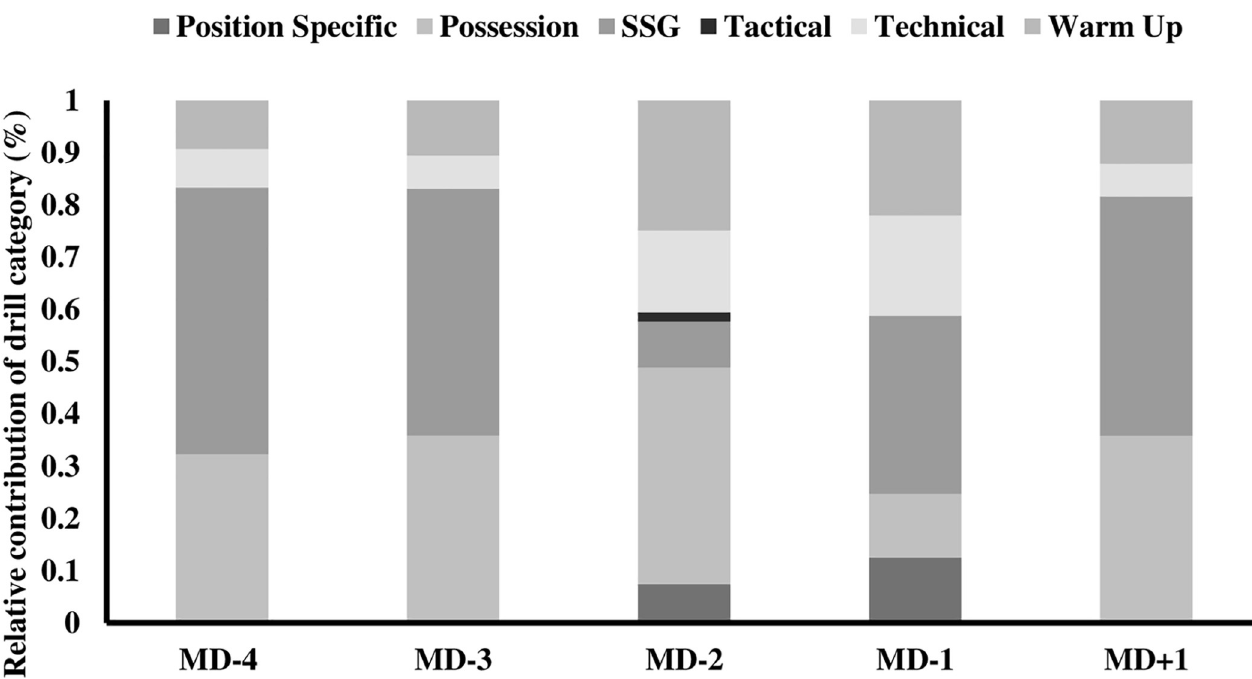
Fig 3. A percentage distribution of training drill categories (warm-up, technical, possession, small-sided game [SSG], playing position specific and tactical) utilised according to match proximity (match day [MD]).